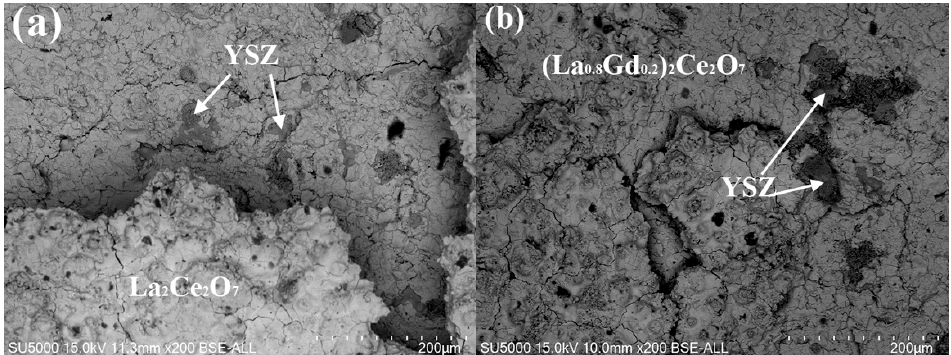
Figure 12. Surface morphologies of the failed thermal barrier coatings: ( a ) LC/YSZ, and ( b ) LGC/YSZ. ( b ) LGC/YSZ.